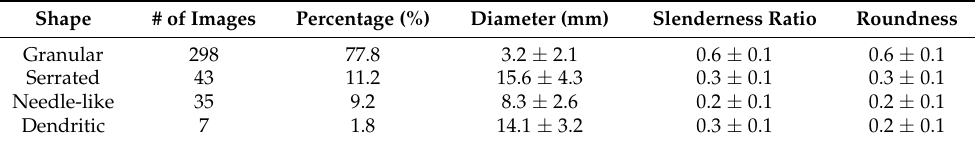
Figure 6. Individual frazil particles: (a–d) granular frazil particles; (e) dendritic frazil particles; (f) needle-like frazil particles; (g,h) serrated frazil particles. Table 1. Microstructural classification of the frazil particles.